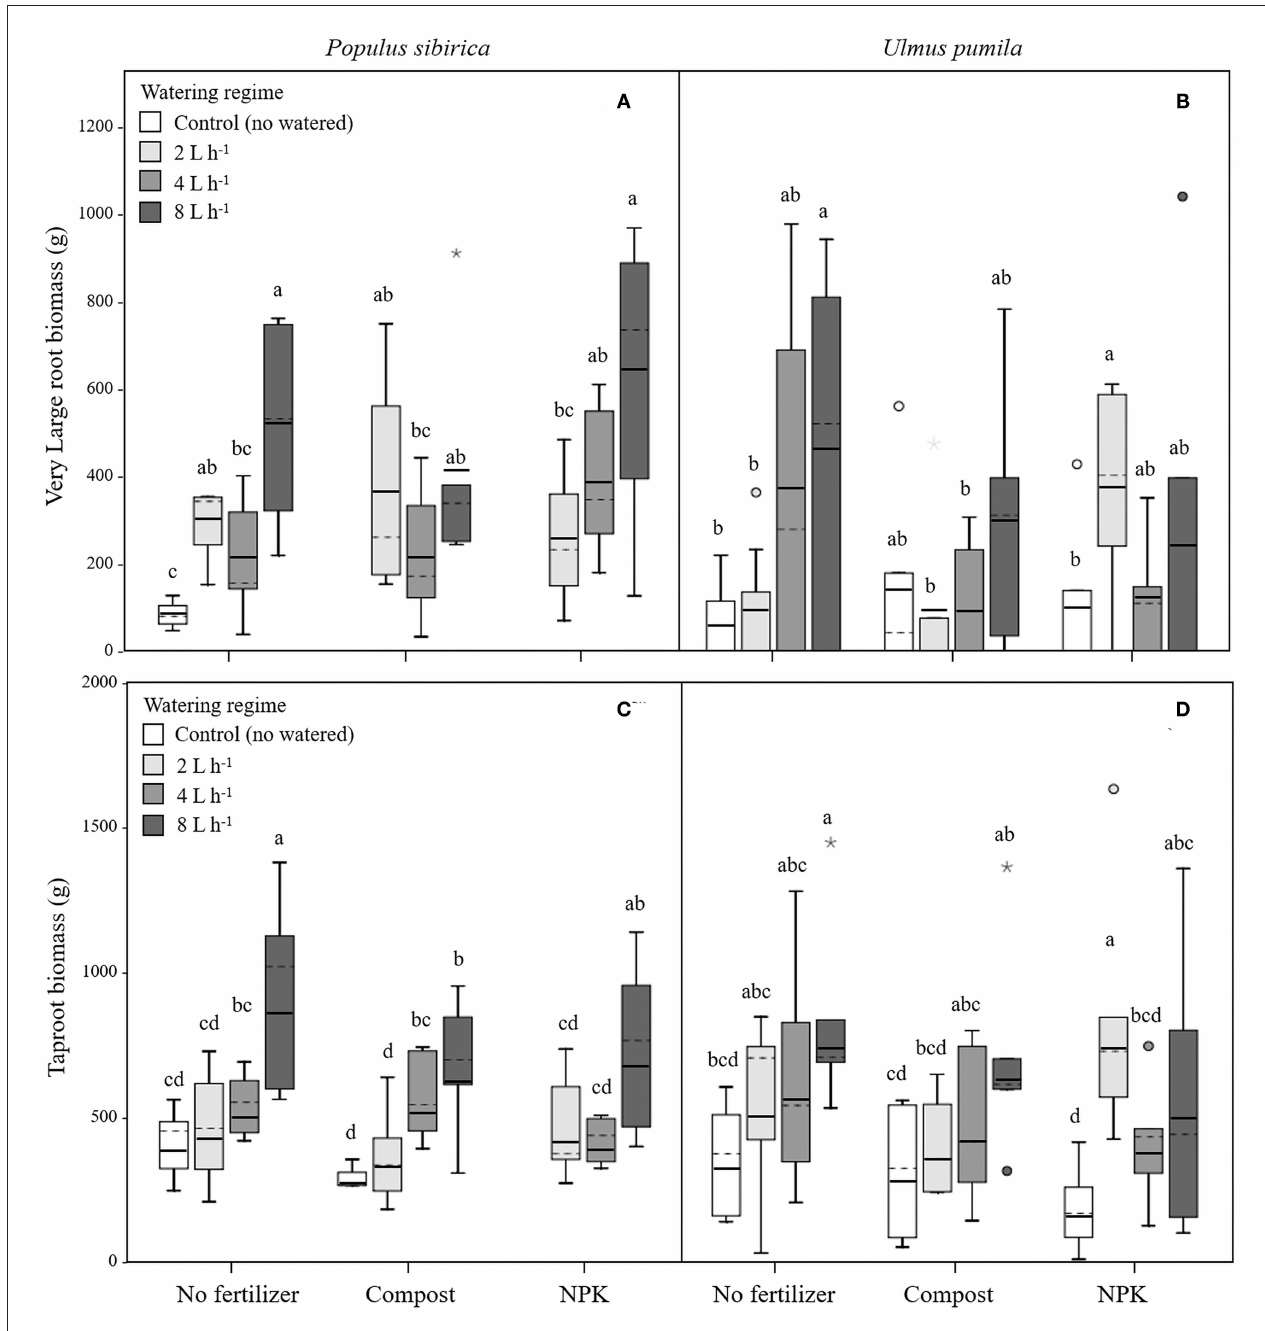
FIGURE 4 | Very large and tap- root biomass for P. sibirica (A,C) and U. pumila (B,D) for different watering regimes and by different fertilization treatments. Different letters indicate significant differences ( p < 0.05) among watering regimes within each fertilization treatment. Vertical boxes represent ∼ 50% of the observations and lines extending from each box are the upper and lower 25% of the distribution. Within each box, the solid horizontal line is the mean value and the dotted line is the median.